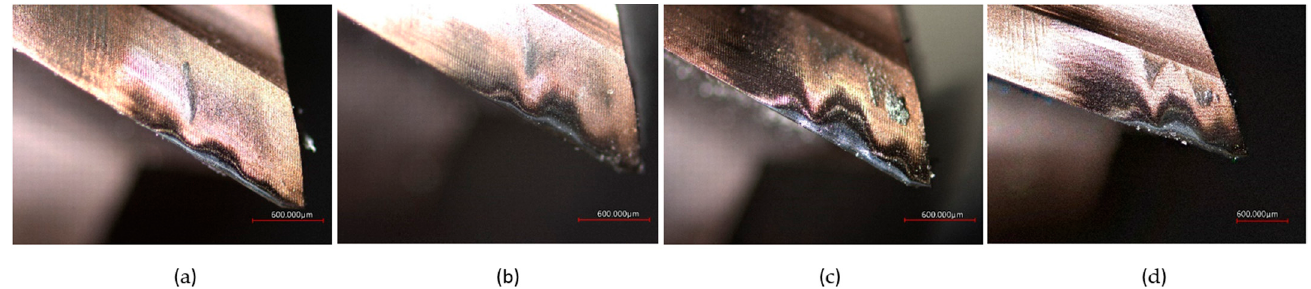
Figure 24. Tool wear of the G550 milling tool, laminate thickness 1 mm. ( a ) Tool tooth path 5 × 165 m; ( b ) tool tooth path 10 × 165 m; ( c ) tool tooth path 15 × 165 m; ( d ) tool tooth path 20 × 165 m.